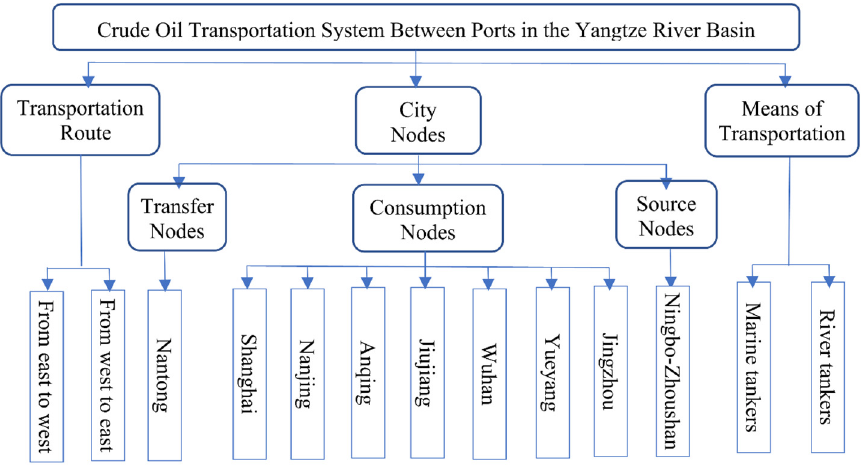
Figure 3. A hierarchical model of the transportation system for crude oil in the Yangtze River.